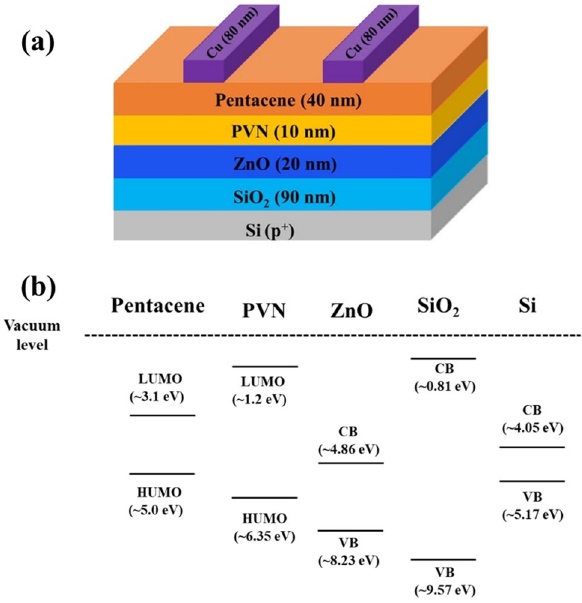
Figure 2. ( a ) The schematic drawing of pentacene OFET with PVN as charge-trapping layer, ( b ) the alignments of energy levels for pentacene, PVN, ZnO and SiO 2 in pentacene